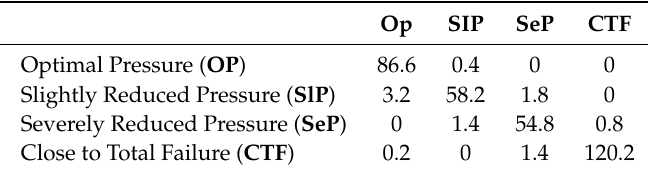
Table 8. Confusion matrix of the Hydraulic Accumulator condition.